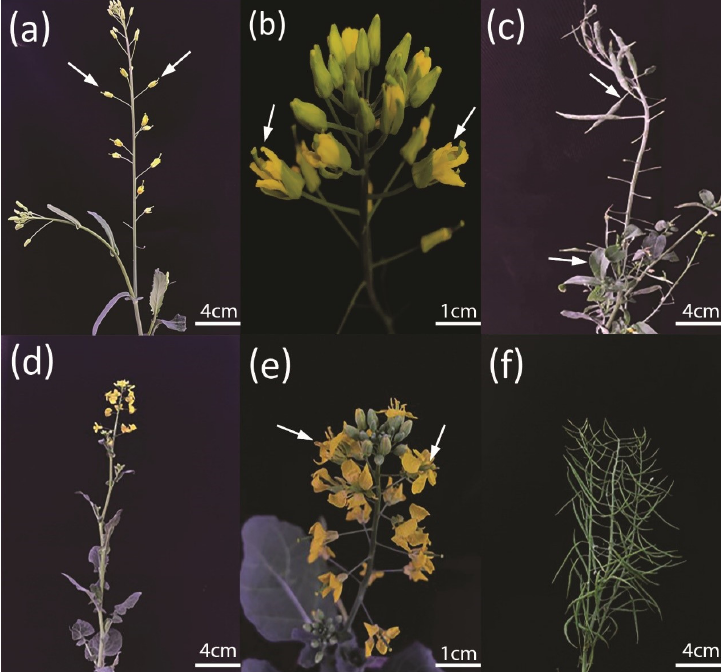
Figure 7. Plant growth stages of bnarfl11 compared to W.T. ( a ) Male-sterile plant at the close flower stage. ( b ) Male-sterile plant at the open-flower stage. ( c ) Male-sterile plants after crossing with wild type with significantly fewer seeds. ( d – f ) Wild-type growth stages compared with those of bnarfl11 .